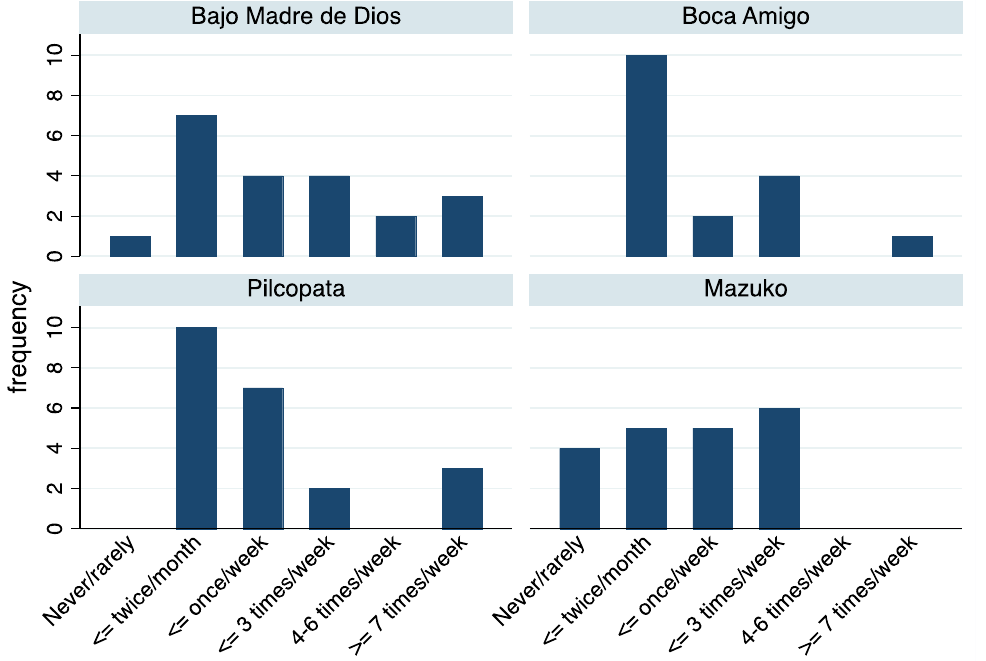
Figure 2. Percent of participants reporting categories of fish consumption frequency at four study sites in the Madre de Dios river basin of Southeastern Peru.